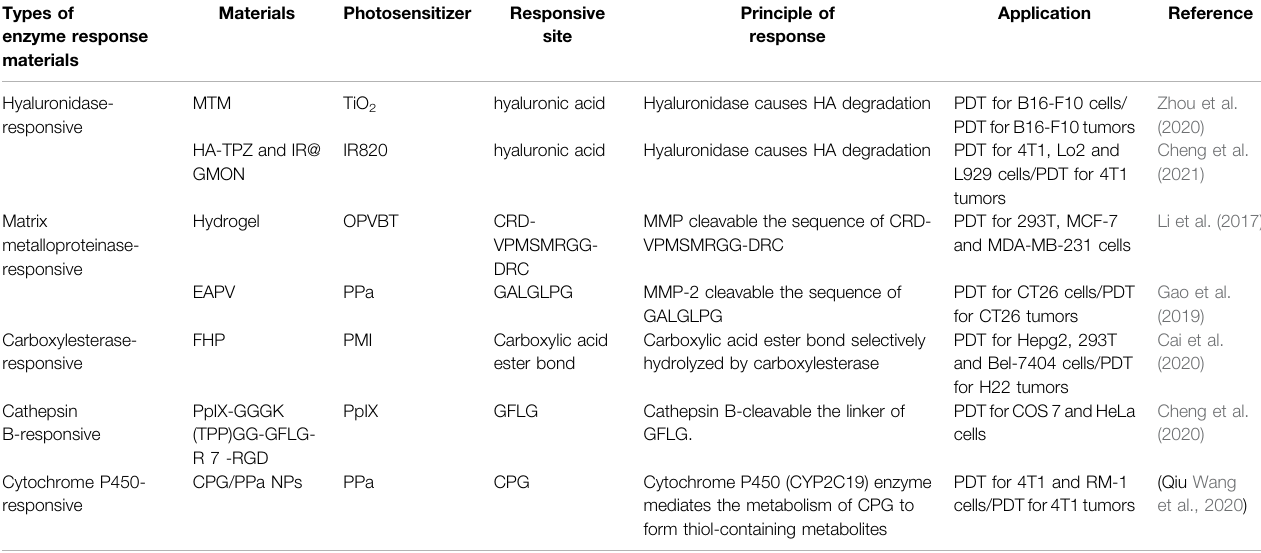
TABLE 1 | Summary of enzyme-response materials for